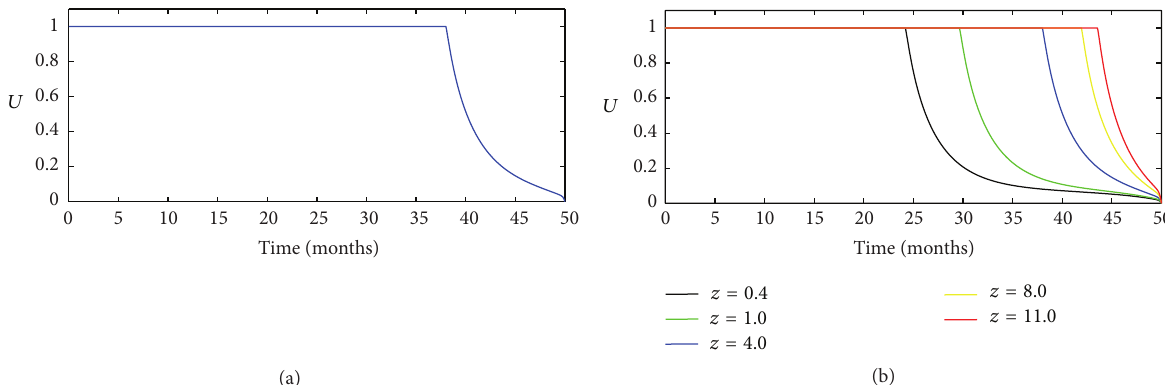
Figure 5: Graphs of the numerical solutions to the behaviour of the control constraint, (a) with the weight constant 𝑧 = 0.4 and (b) with the weight constant 𝑧 being varied.